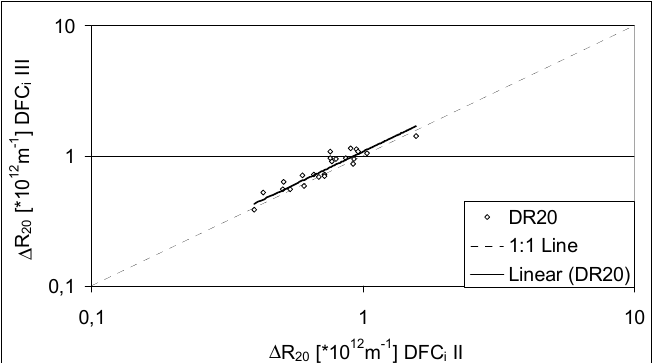
, obtained at two Delft Filtration Characterization Figure 4. Filterability, as Δ R 20 Installations: DFCi II and DFCi III. (Adapted from Krzeminski